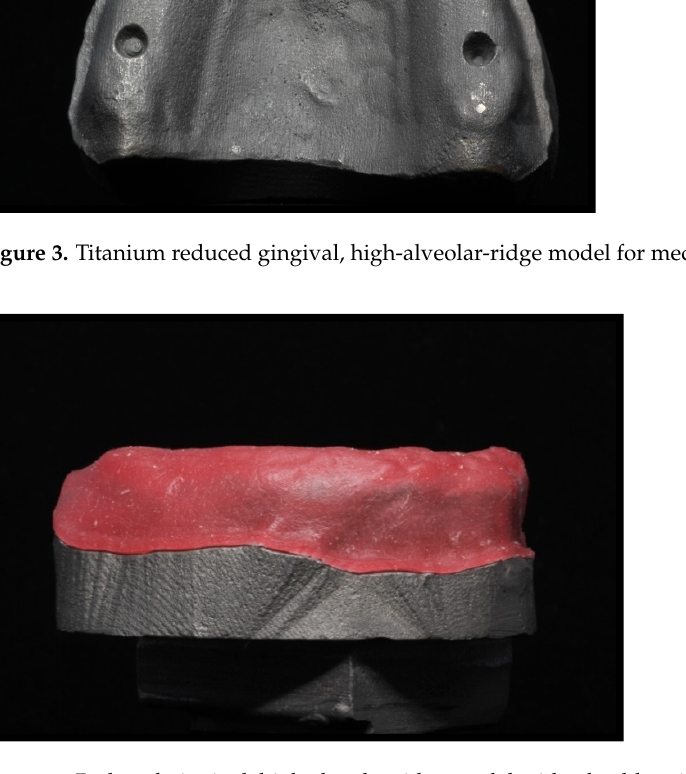
Figure 4. Reduced gingival, high alveolar ridge model with a healthy gingival mucosa replica made using silicone shore A-30.